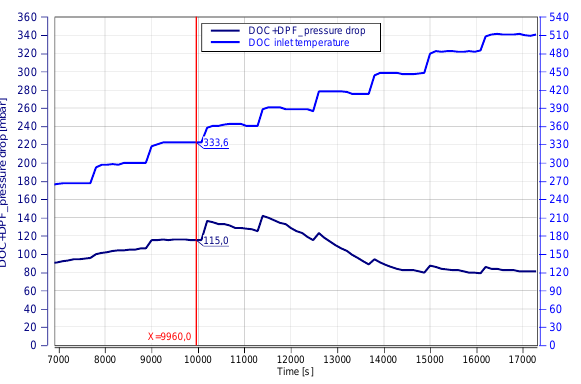
Fig. 9. DOC-DPF balance point test results